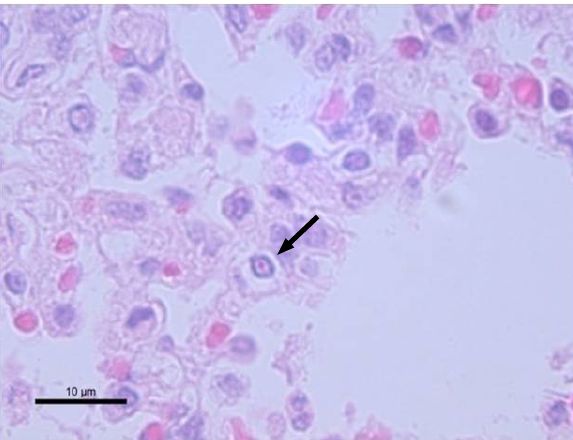
Figure 2. Aborted equine fetal lung tissue (Fetus 2). Intranuclear acidophilic inclusion body of alveolar pneumocytes at necrosis foci in the parenchyma (arrow). Scale bar10µm.